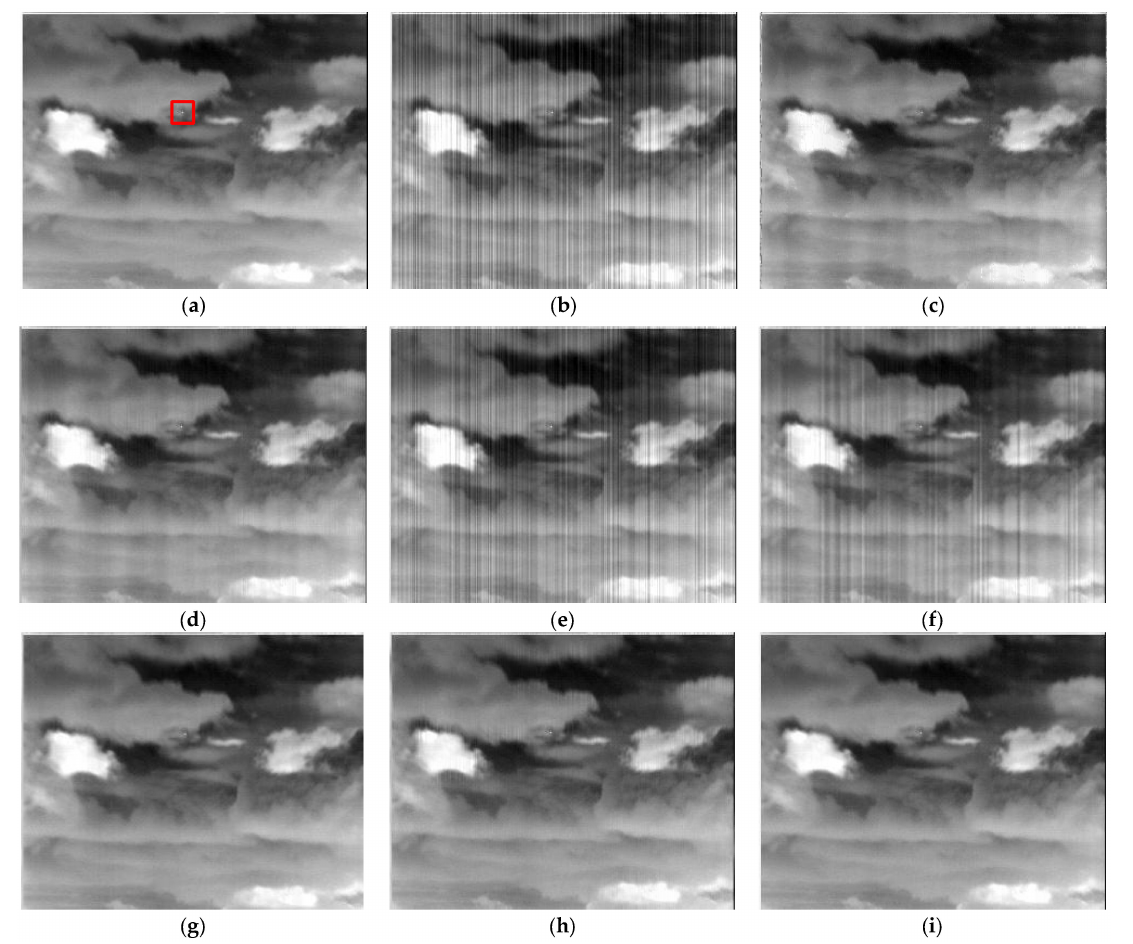
Figure 14. The nonuniformity correction results of Test-10: ( a ) the real, clean infrared dim small target image ( B var = 2880), the dim small target is located in the middle of the red box we manually marked; ( b ) infrared dim small target image with nonuniform noise added; ( c ) MHE; ( d ) 1D-GF;